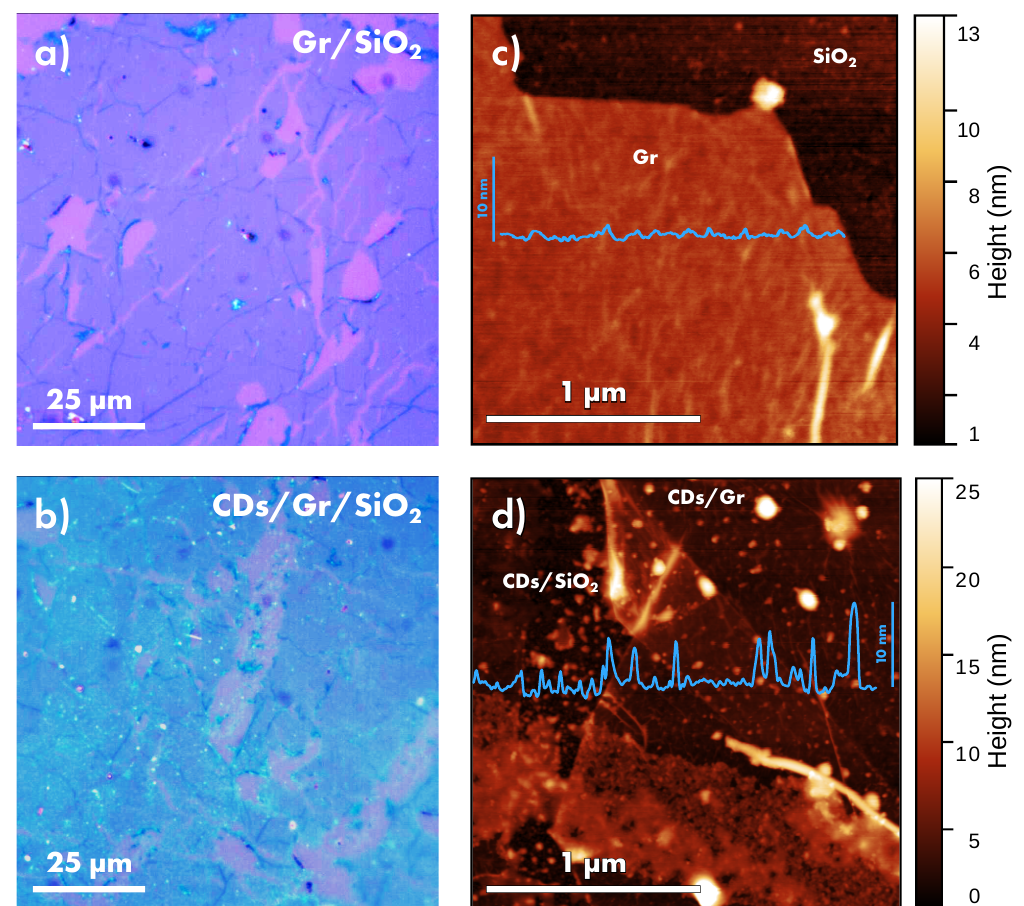
Figure 3. Surface morphology evaluated by ( a , b ) optical microscopy, and by ( c , d ) atomic force microscopy of Gr/SiO 2 and CDs/Gr/SiO 2 , respectively. In panel ( d ), the CDs deposited on SiO 2 (CDs/SiO 2 ) and CDs deposited on graphene (CDs/Gr) can be distinguished. In addition, in panels (c,d), representative profile is reported (blue line) on the corresponding section